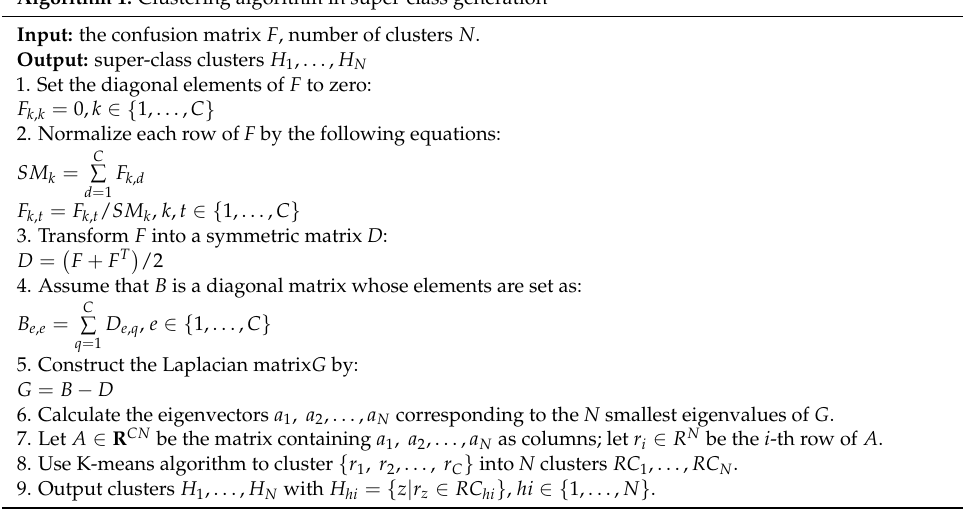
Algorithm 1. Clustering algorithm in super-class